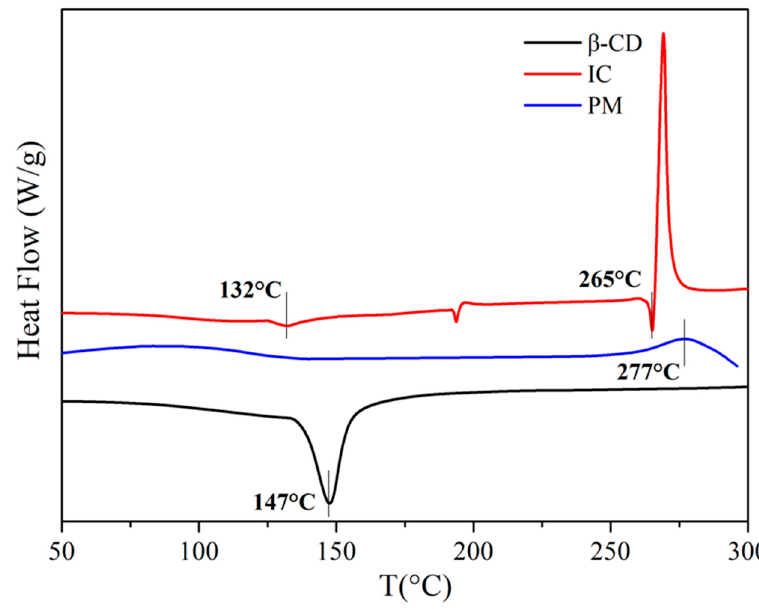
Figure 4. DSC curves of PM, IC and β -CD under N 2 .